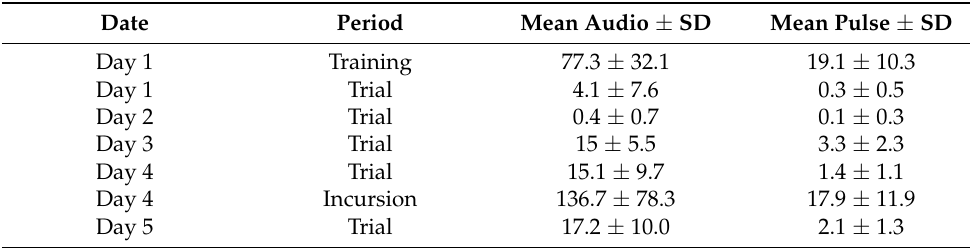
Table 1. Daily mean ( ± SD) number of audio cues and electrical pulses across all 10 animals at Lameroo 1 .